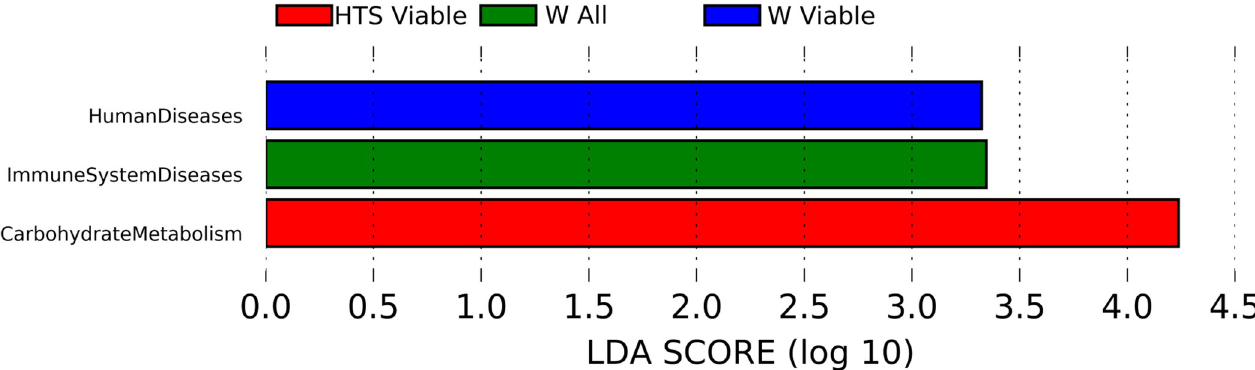
Fig 10. Differing KEGG orthologs between regimens level 2 KEGG othologs of predicted metabolic pathways following the different pre-feeding regimens. HTS; carbohydrate metabolism (n = 7), W; human diseases (n = 11) and immune system disease (n = 7).